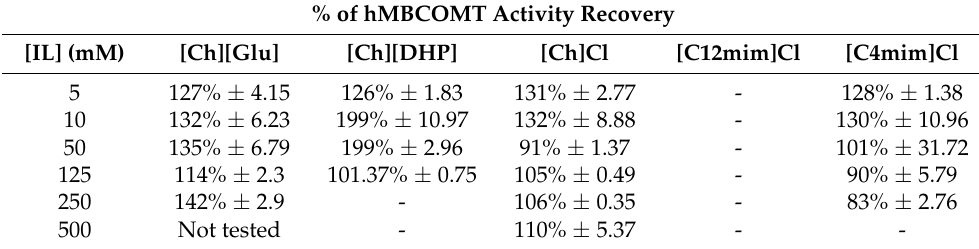
Table 1. hMBCOMT activity recovery in contact with different ILs in comparison with enzyme lysate samples without the IL